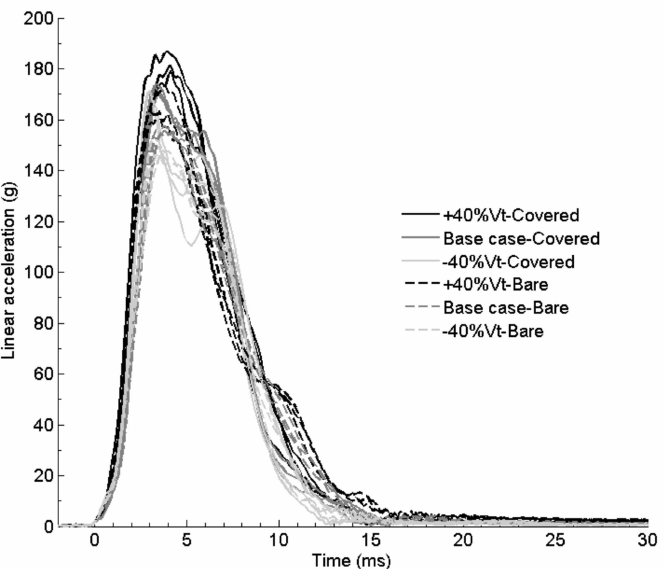
Figure 7. Resultant linear acceleration for the left side impacts. Solid lines correspond to covered headform and dashed lines correspond to bare headform